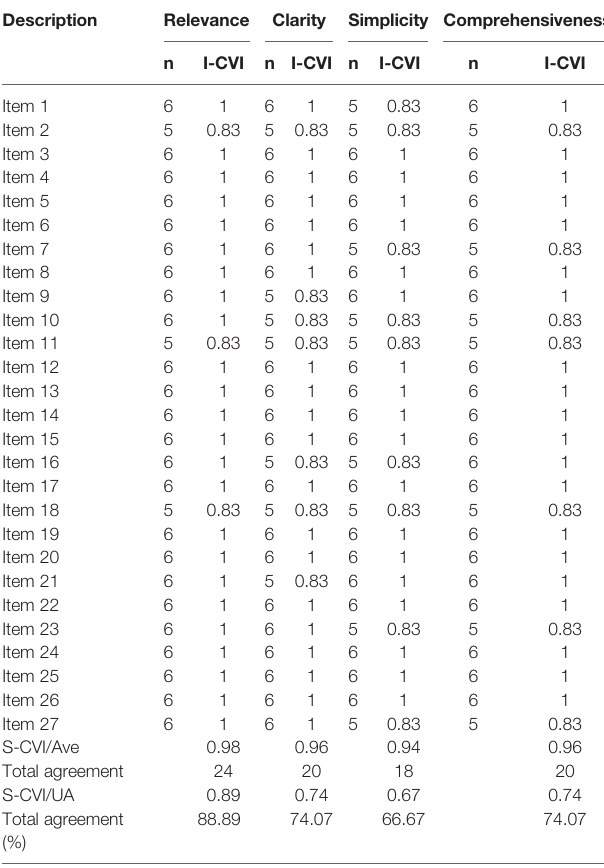
TABLE 1 | Content validity of the 27-item draft healthcare workers ’ knowledge, attitudes, and practices instrument for uncomplicated malaria scale (N = 6). Description